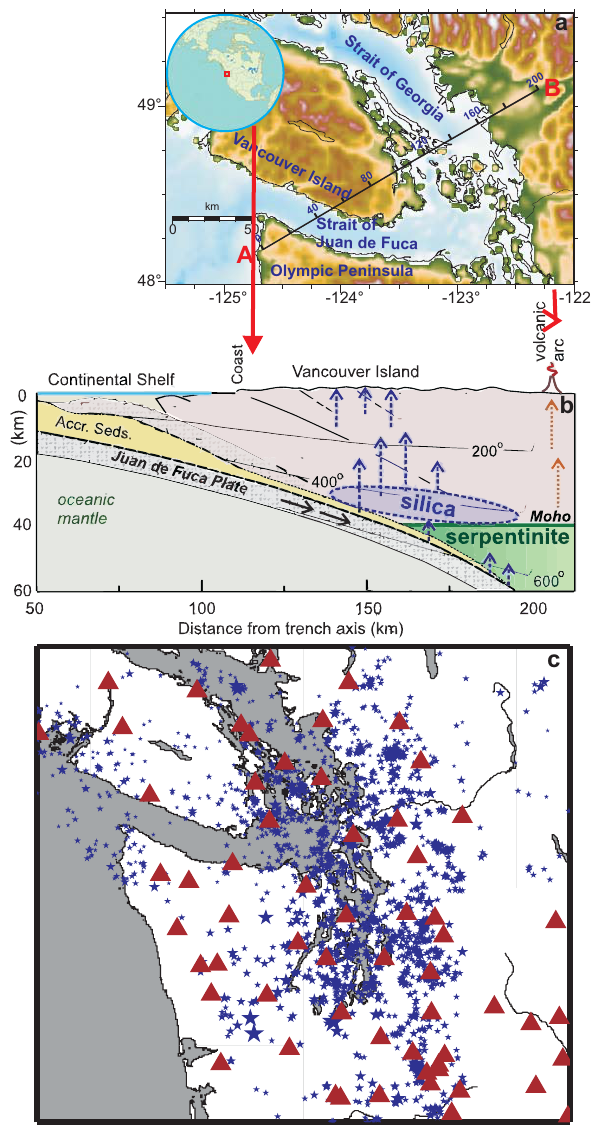
Fig. 1. (a) Location map of the study region. Distance along the profile is marked in kilometers. (b) schematic along line AB show- ing the subduction zone structure. (c) map view of stations and earthquakes used in tomography. Vertical cross-sections of P- and S-wave velocity along profile AB are shown in Fig.